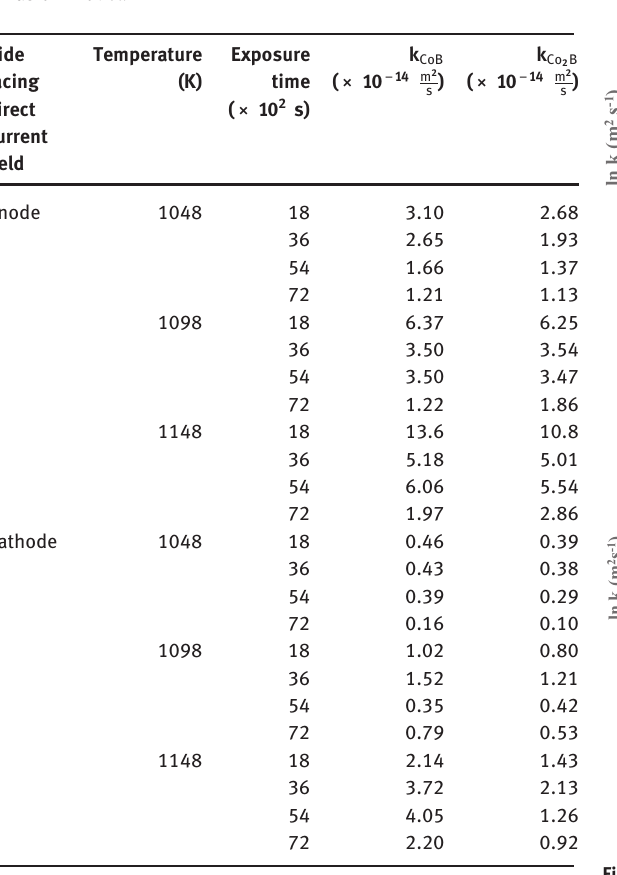
Table 1: Estimated values of the growth constants obtained by the diffusion model.